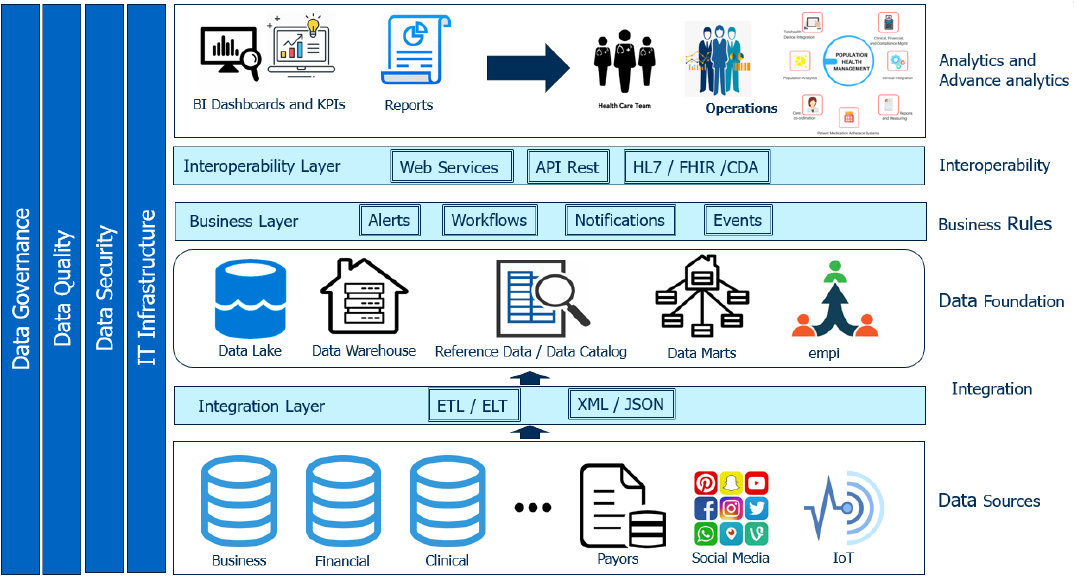
Figure 1. Conceptual Framework—Keralty Health